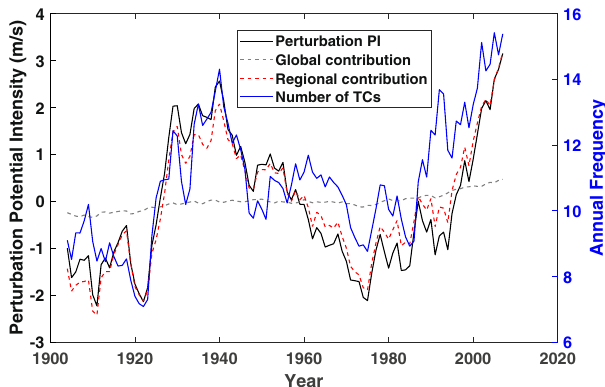
Fig. 4 Comparison of Atlantic tropical cyclone frequency to potential intensity anomaly and decomposition of potential intensity into global and regional contributions. Seven-year running means of Atlantic Main Development region (6° – 18° N, 20° – 60° W) August – October departures of potential intensity (black, ms − 1 ) from its mean over the record, and its decomposition into global (dashed green) and regional (dashed red) components. The 7-year running mean of the annual frequency of tropical cyclones downscaled from CERA-20C is shown in blue (right